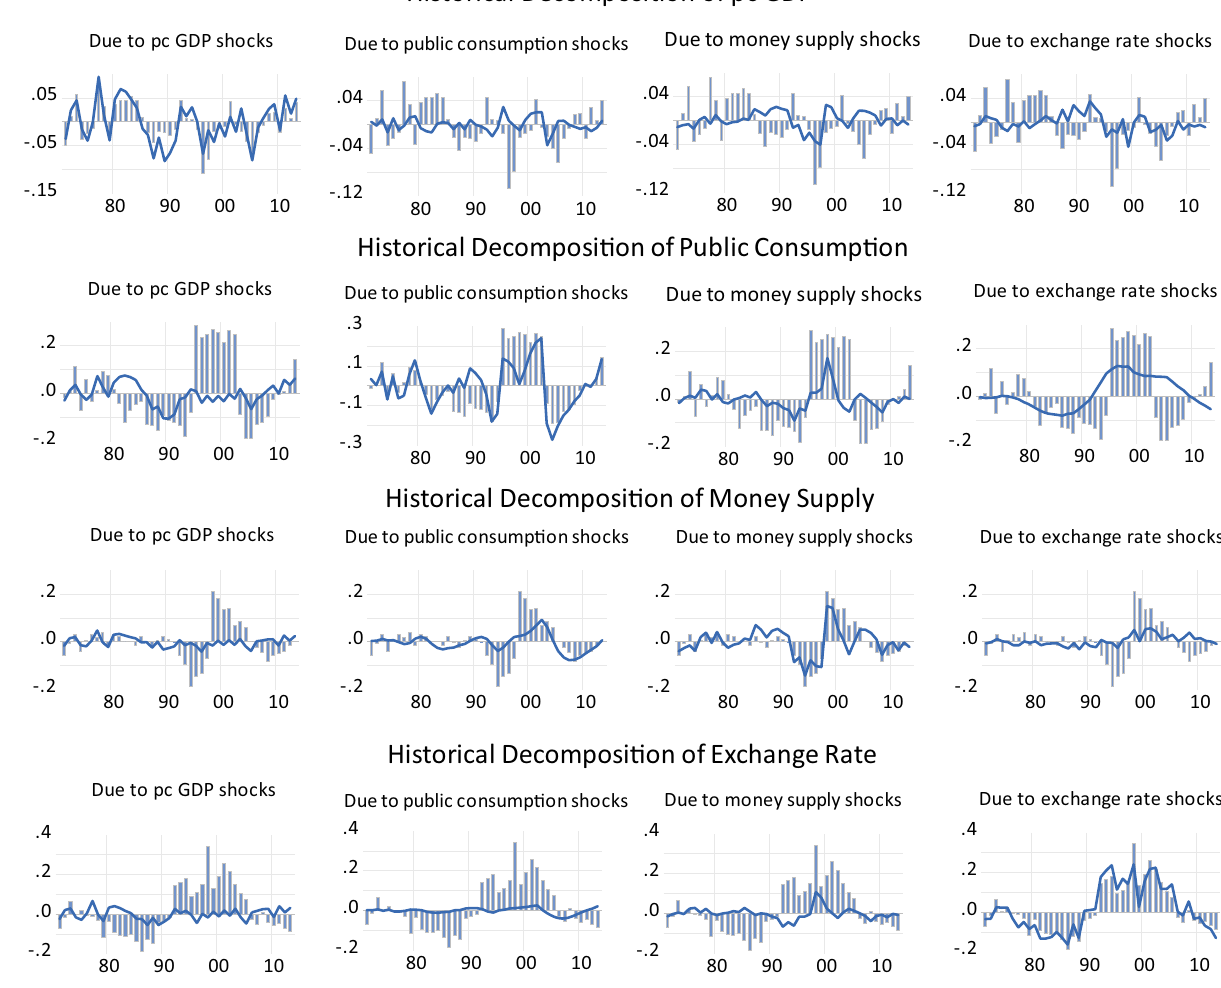
Figure 7: Historical decomposition ( Spain )